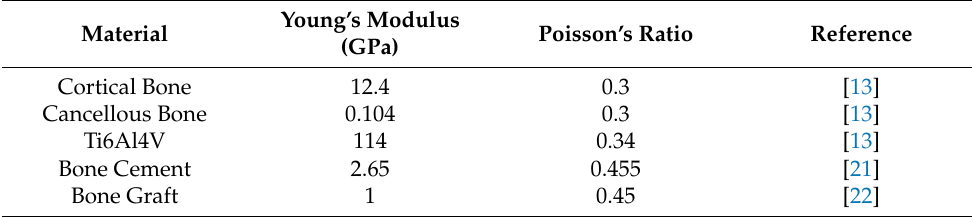
Table 1. Material properties used in FE analysis.